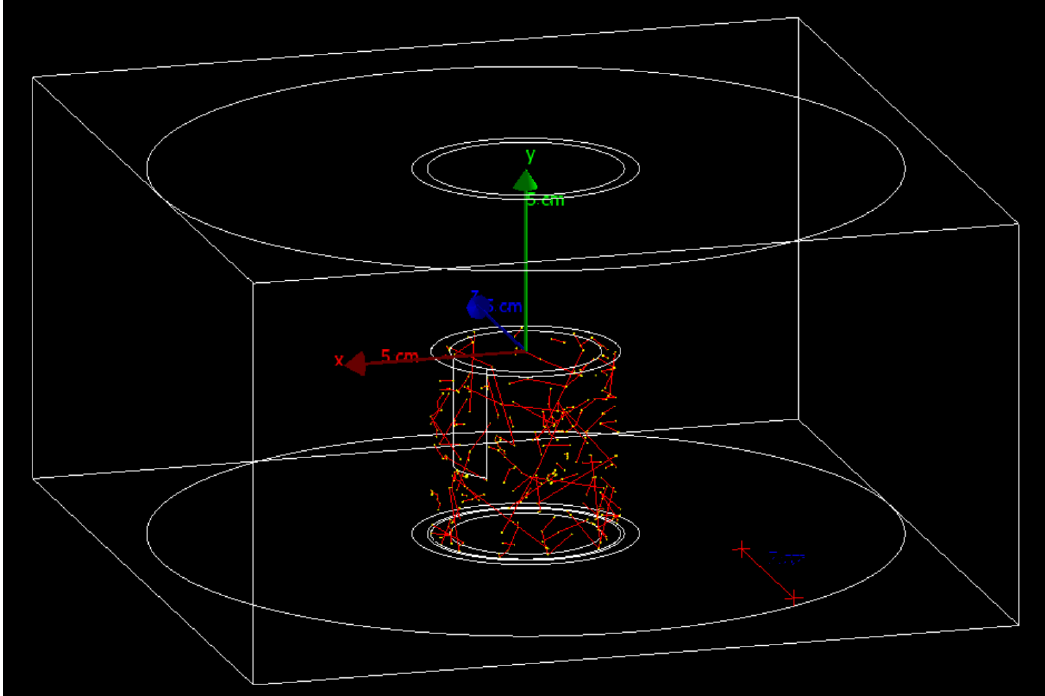
Figure 5. A flexible CdTe detector, white rectangle, applied to the surface of a cylindrical detector, as depicted in the Geant4 simulation with decaying 90 Sr , yellow dots, and beta particles, red lines. Some surfaces have been hidden for